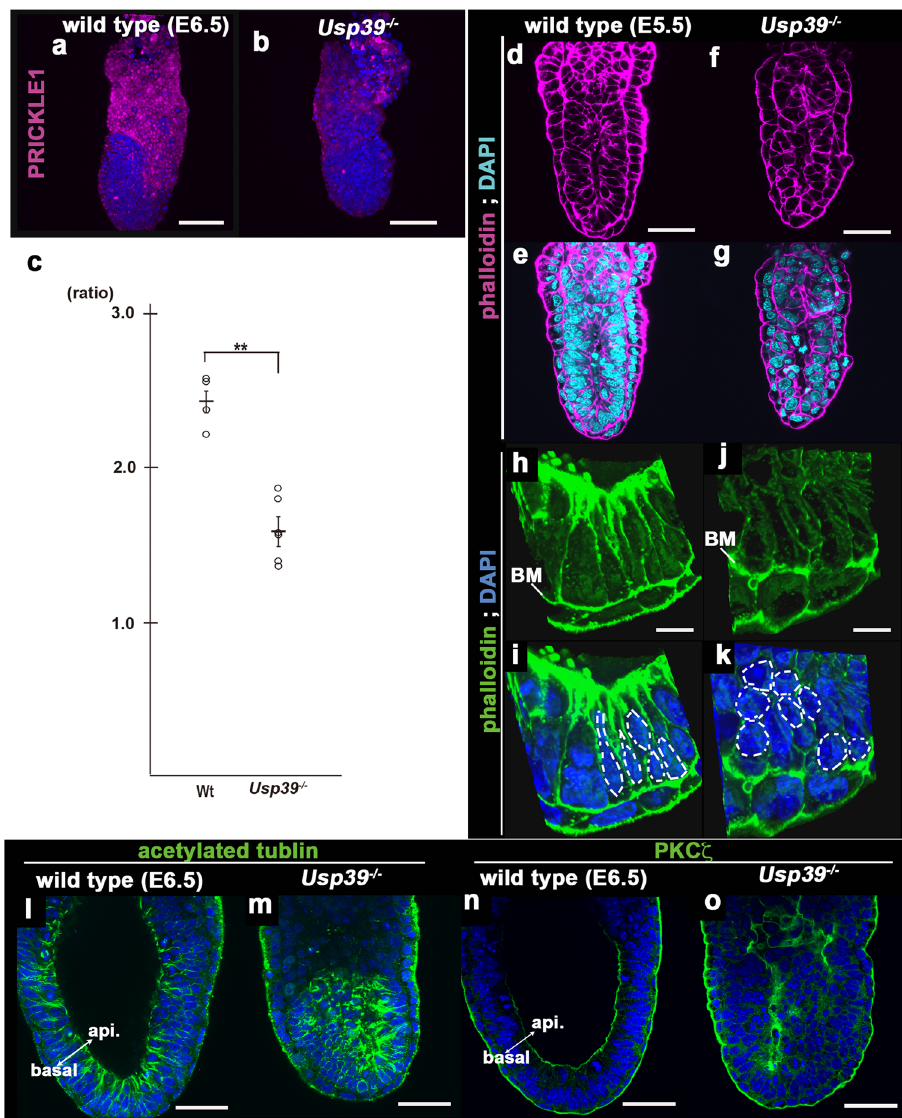
Fig. 5 Usp39 − / − mutation embryos display aberrant apico-basal polarity in the epiblast. a , b , d – o Immunohistochemical and fl uorescence analyses. PRICKLE1 (magenta) and 4,6 ′ -diamidino-2-phenylindole (DAPI; blue) in wild-type ( a ) and Usp39 − / − ( b ) embryos at E5.5. Phalloidin ( d – k ), acetylated- tubulin ( l , m ), protein kinase C (PKC)- ζ ( n , o ) and DAPI in wild-type ( d , e , h , i , l , n ) and Usp39 − / − ( f , g , j , k , m , o ) embryos at E5.5 ( d – g ) and E6.5 ( h – o ). Usp39 − / − epiblasts have defective cytoskeletal actin polarization and abnormal localization of acetylated tubulin and PKC ζ on a sagittal orientation ( m , o ). c Quanti fi cation of epiblast nuclei in wild-type and Usp39 − / − embryos at E5.5. Double astersik denotes a signi fi cant difference ( p < 0.01 ) compared with control (see Fig. S6). Scale bars represent 10 μ m ( h – k ), 50 μ m ( d – g , l , m ), and 100 μ m ( a , b